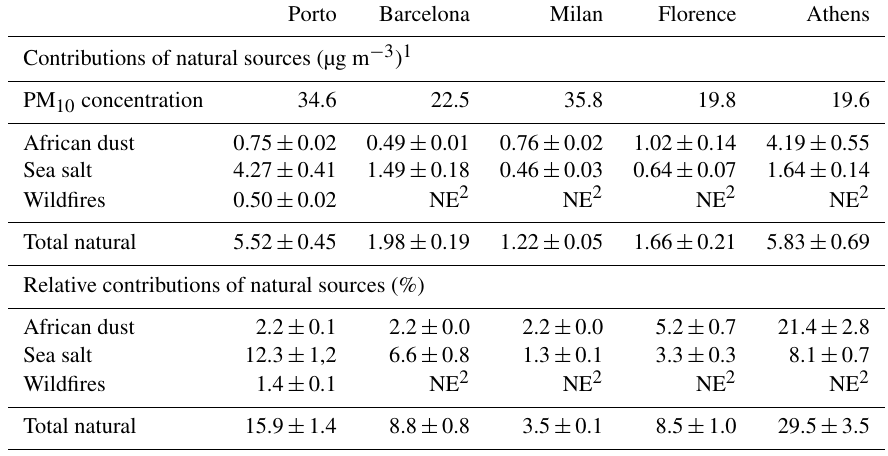
Table 2. Mean annual natural source contributions to the PM 10 concentrations and corresponding uncertainties, for the five AIRUSE cities.